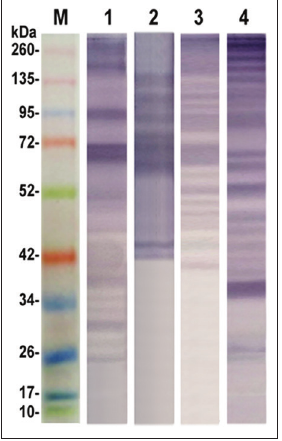
Figure-2: Immunogenic reactivity profile of excretory- secretory Cyathostomins spp. antigen (Lane 1), excretory- secretory Strongylus vulgaris antigen (Lane 2), crude somatic Cyathostomins spp. antigen (Lane 3), crude somatic S. vulgaris antigen (Lane 4) against control positive sera and pre-stained molecular weight protein ladder, Fermentas (Lane M, 10-260 kDa).